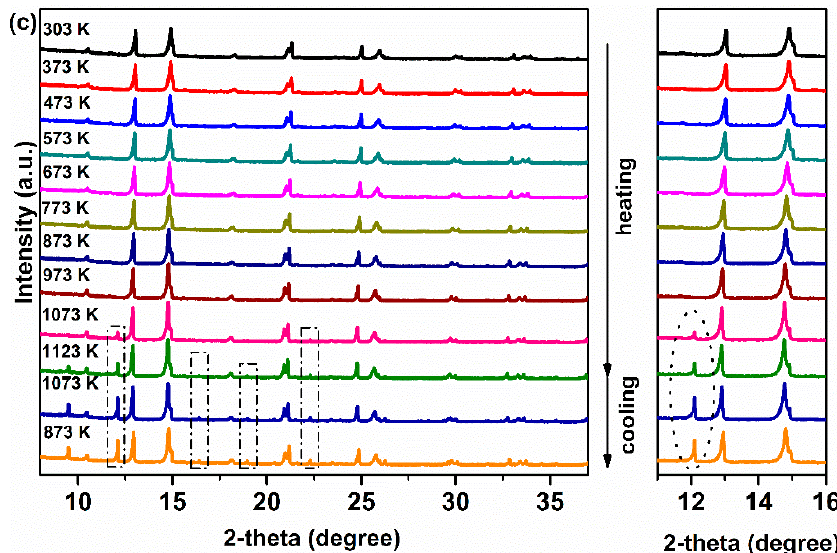
Figure 6. In situ XRD patterns of Ce 0.9 Pr 0.1 O 2 − δ –Nd x Sr 1 − x Fe 0.9 Cu 0.1 O 3 − δ powders in air: ( a ) Ce 0.9 Pr 0.1 O 2– δ –Nd 0.2 Sr 0.8 Fe 0.9 Cu 0.1 O 3 − δ ; ( b ) Ce 0.9 Pr 0.1 O 2 − δ –Nd 0.5 Sr 0.5 Fe 0.9 Cu 0.1 O 3 − δ ; ( c ) Ce 0.9 Pr 0.1 O 2 − δ –Nd 0.8 Sr 0.2 Fe 0.9 Cu 0.1 O 3 − δ .